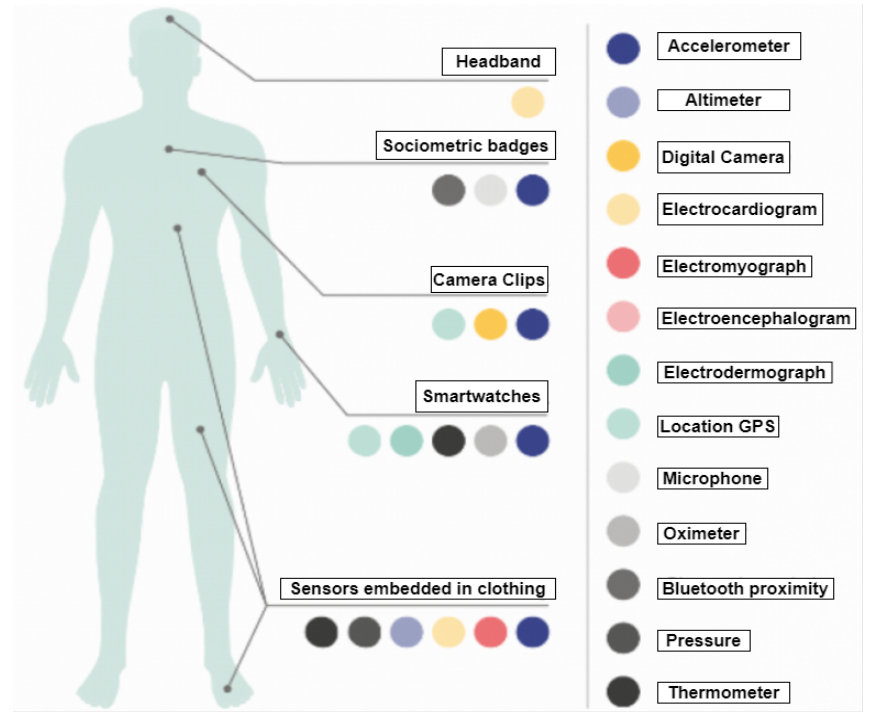
Figure 2. Wearables based on on-body location [57]